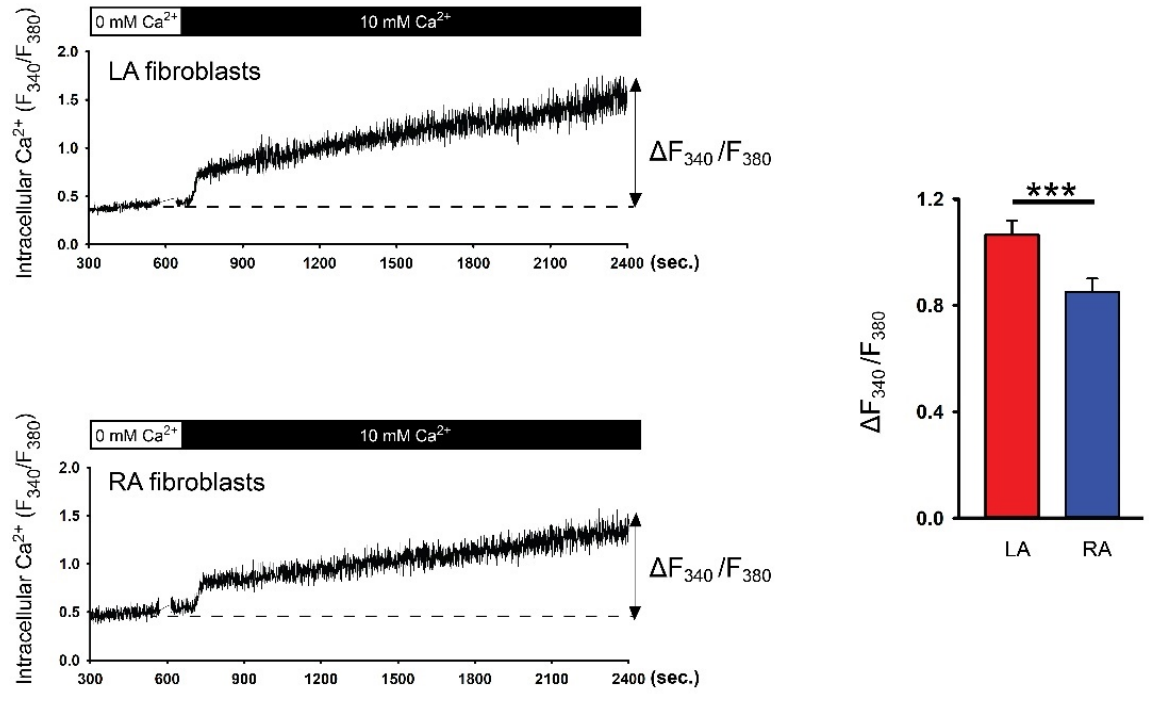
Figure 1. Ca 2+ entry in the isolated passage 0 (P0) left atrium (LA) and right atrium (RA) fibroblasts from healthy rats. Left panels represent intracellular Ca 2+ tracing from the LA fibroblasts (upper tracing, n = 18 LA fibroblasts from four rats) and RA fibroblasts (lower tracing, n = 17 RA fibroblasts from four rats). The cells were first incubated with a Ca 2+ -free extracellular solution to deplete the Ca 2+ stores. Ca 2+ entry was induced after increasing extracellular Ca 2+ to 10 mmol/L. Right panels show the change in intracellular Ca 2+ from a Ca 2+ -free solution to a 10 mmol/L Ca 2+ solution ( ∆ F 340 /F 380 ). *** p < 0.005.